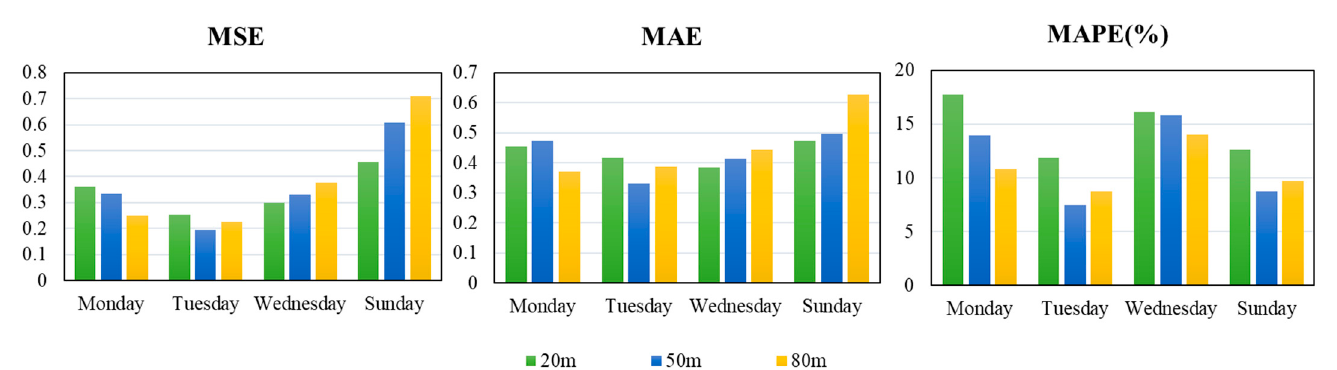
Table 3. The evaluation index of Elman.